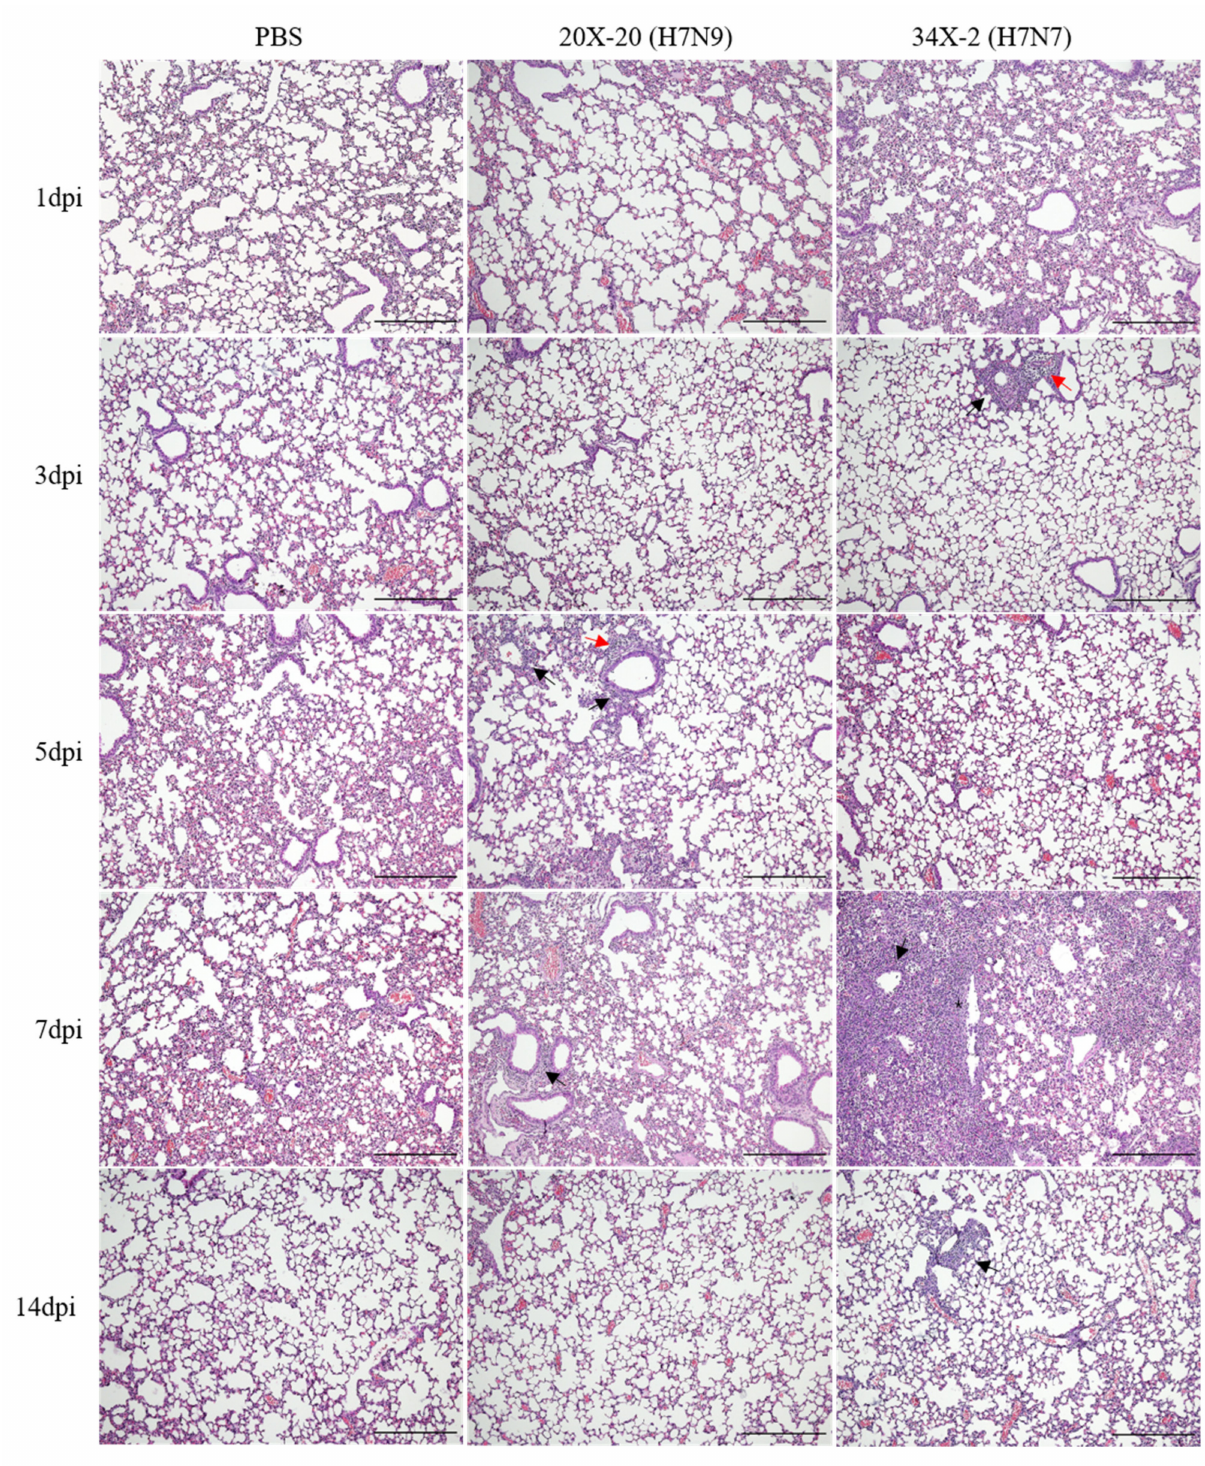
Figure 4. Histopathology analysis of the lungs of mice inoculated with 20X-20 and 34X-2. Lung tissue sections from mice were stained with hematoxylin and eosin. Inflammatory cells infiltrated into the peribronchiolar (black arrow) and perivascular regions (red arrow) of the lungs of mice infected with 20X-20 (H7N9) and 34X-2 (H7N7) viruses can be visualized. Interstitial pneumonia and degeneration of bronchial epithelium (asterisk) were observed in 34X-2 (H7N7)- infected mice on 7 dpi. The original magnification is × 100 and the scale bar indicates 200 µ m. Dpi, days